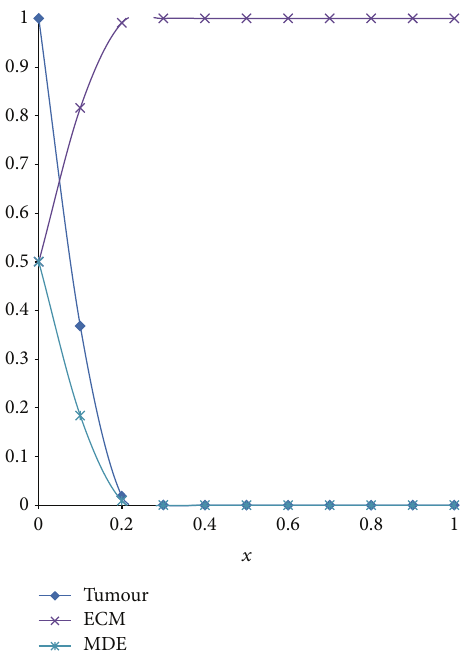
Figure 4: One-dimensional MDM and HPM solution of the system (3)–(5) with constant tumour cell diffusion showing the cell density, MDE concentration, and ECM density at 𝑡 = 0 .